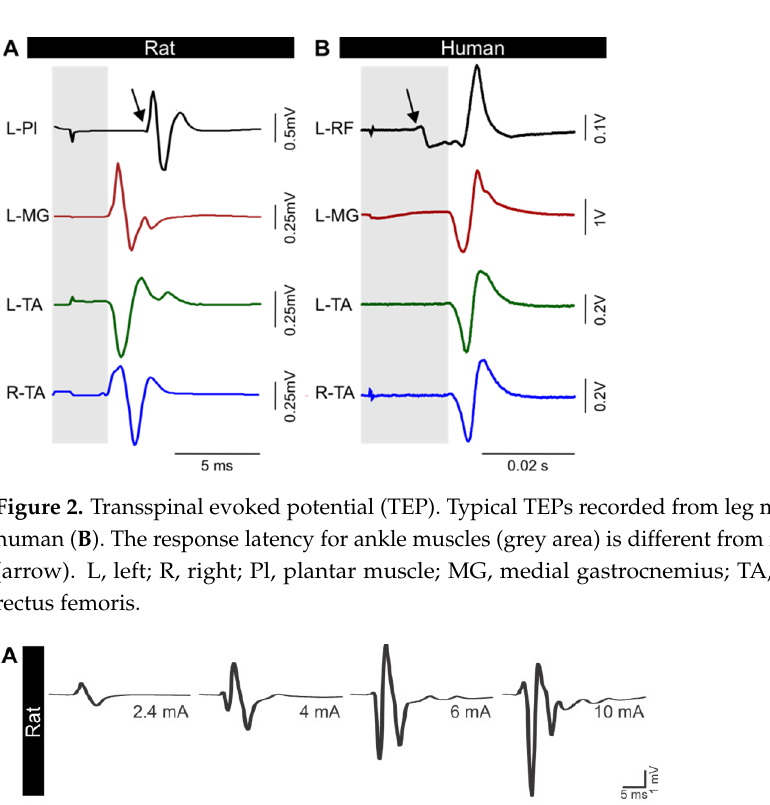
Figure 2. Transspinal evoked potential (TEP). Typical TEPs recorded from leg muscles in rat ( A ) and human ( B ). The response latency for ankle muscles (grey area) is different from muscle at other joints (arrow). L, left; R, right; Pl, plantar muscle; MG, medial gastrocnemius; TA, tibialis anterior; RF, rectus femoris.